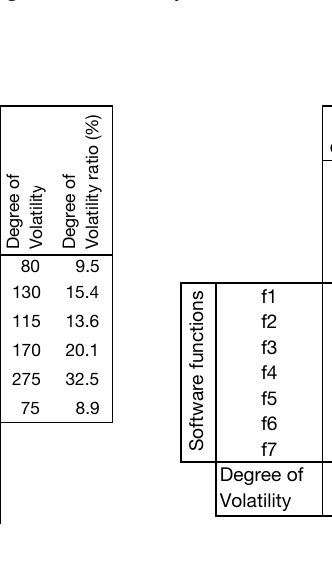
Table 1. A sample of obtaining the degree of volatility of customer